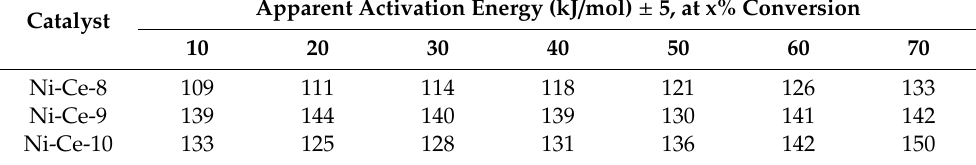
Table 6. Apparent activation energy (E a ) calculated from Ozawa plots at di ff erent soot conversions. The activation energy of non-catalytic soot at T 50 is 168 KJ / mol.